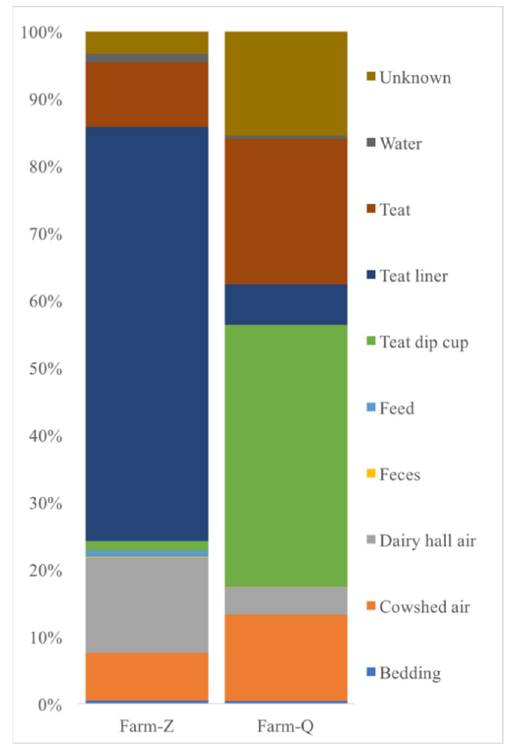
Figure 5. Source Tracker results highlight the percentages of inferred sources of contamination in milk samples. Farm-Z: Zhengzhou farm, Farm-Q: Qiqihar farm.